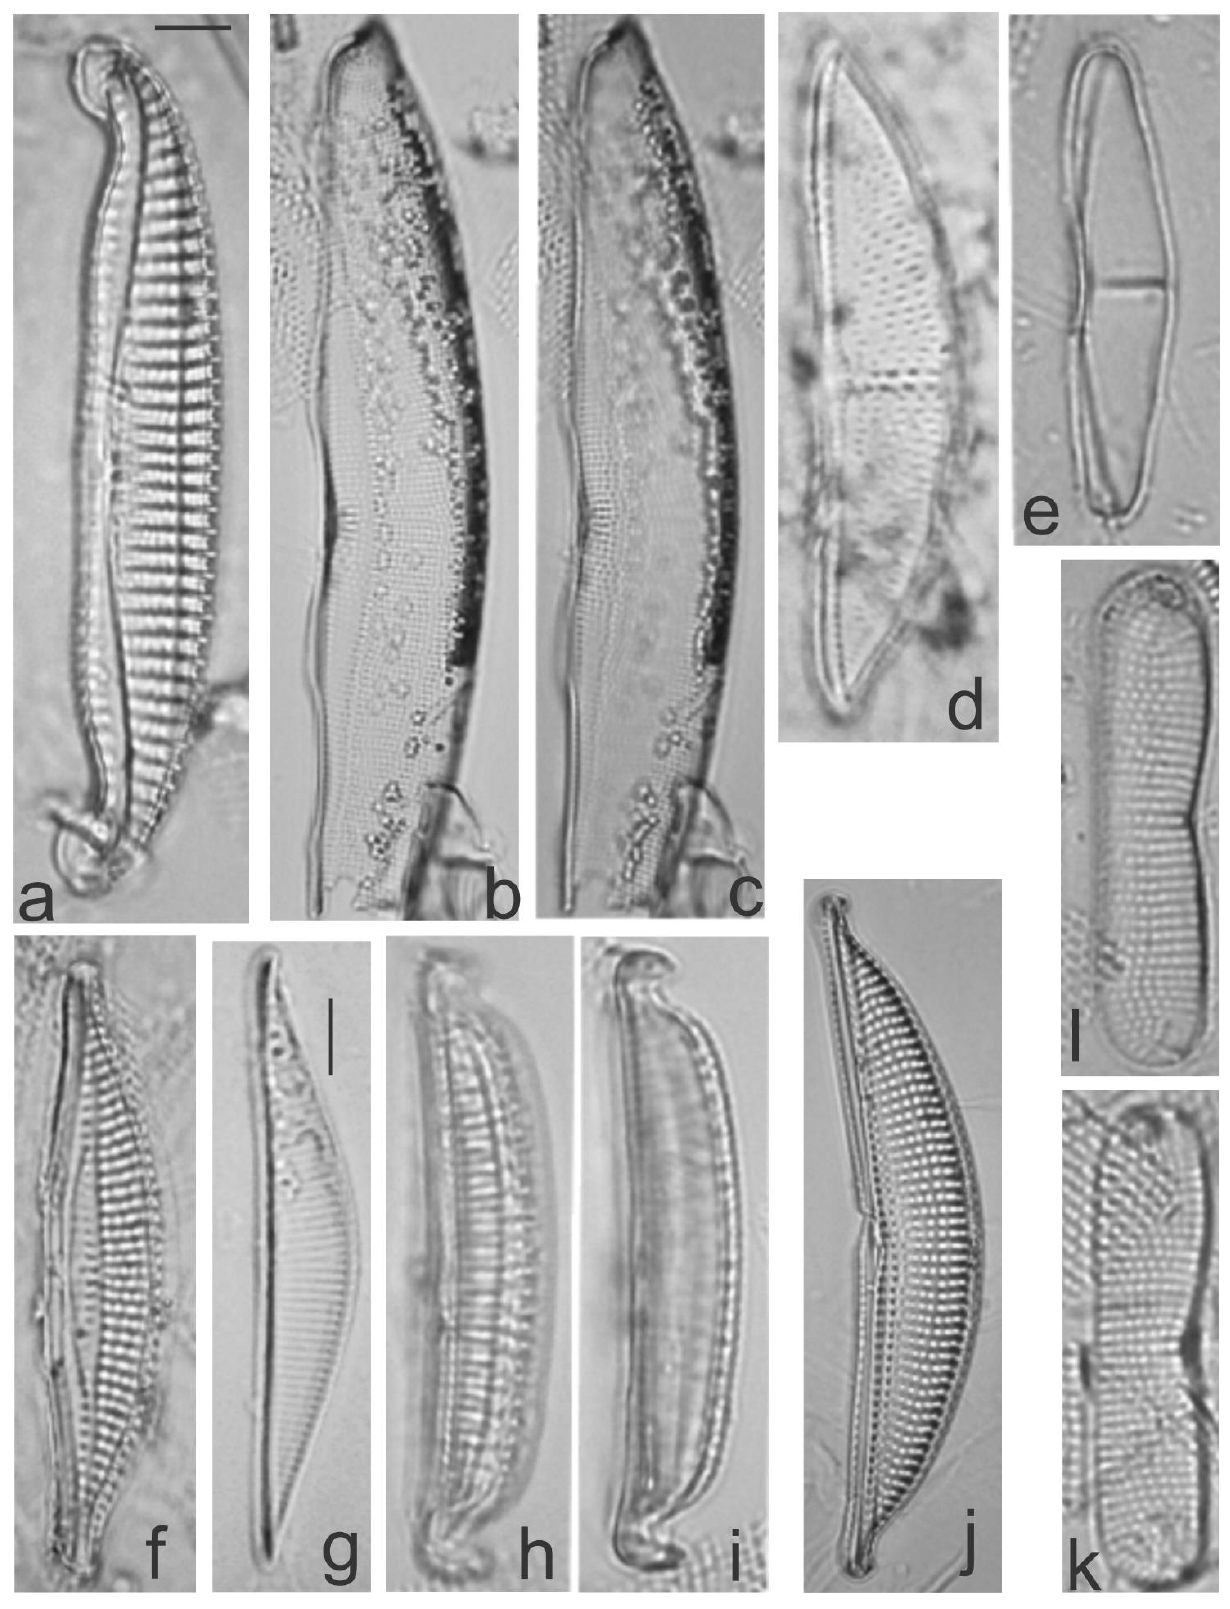
Figure 25. ( a ) Amphora crassa var. campechiana ; ( b , c ) A. alternata ; ( d ) A. novaecaledonica ; ( e ) Amphora laevissima ; ( f ) A. grevilleana var. campechiana ; ( g ) Amphora cf. praelata ; ( h , i ) A. capensis ; ( j ) Halamphora clara ; ( k , l ) Colliculoamphora minima . Scale bar = 5 μm.